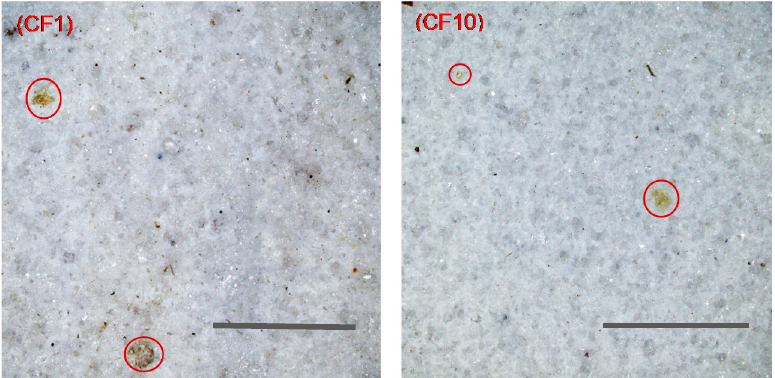
Figure 6. Confocal microscopy images of the surfaces of CF1 and CF10 (magnification 5×, scale bars represent 1 mm). represent 1 mm).